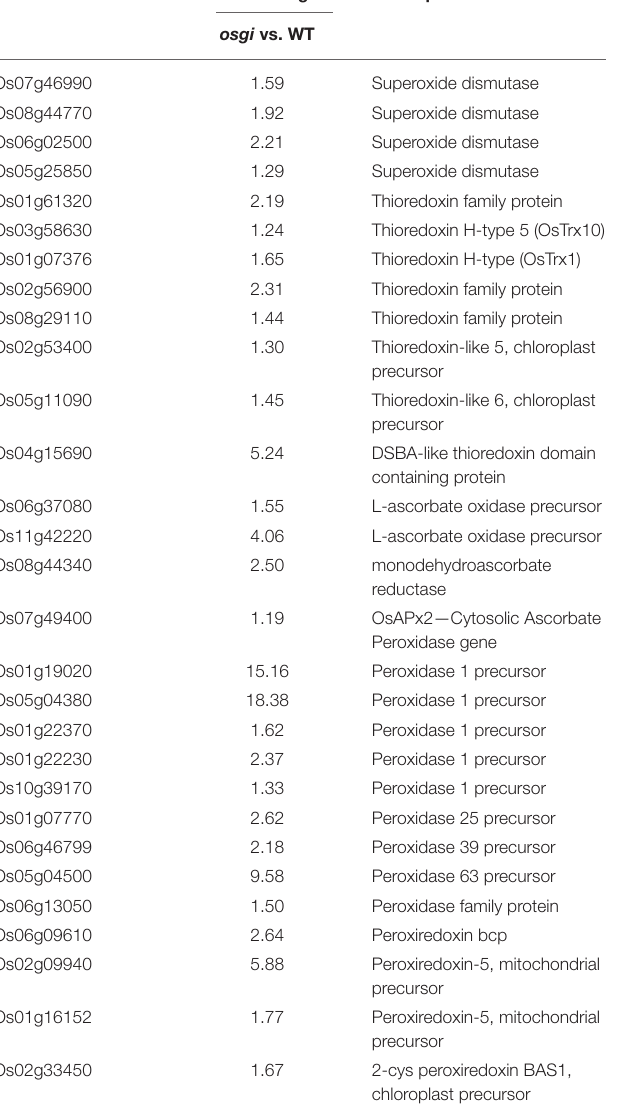
TABLE 2 | Genes involved in antioxidant synthesis with significantly altered transcript abundance in osgi compared to WT leaves ( p < 0.05). TIGR locus identifier Fold change Description